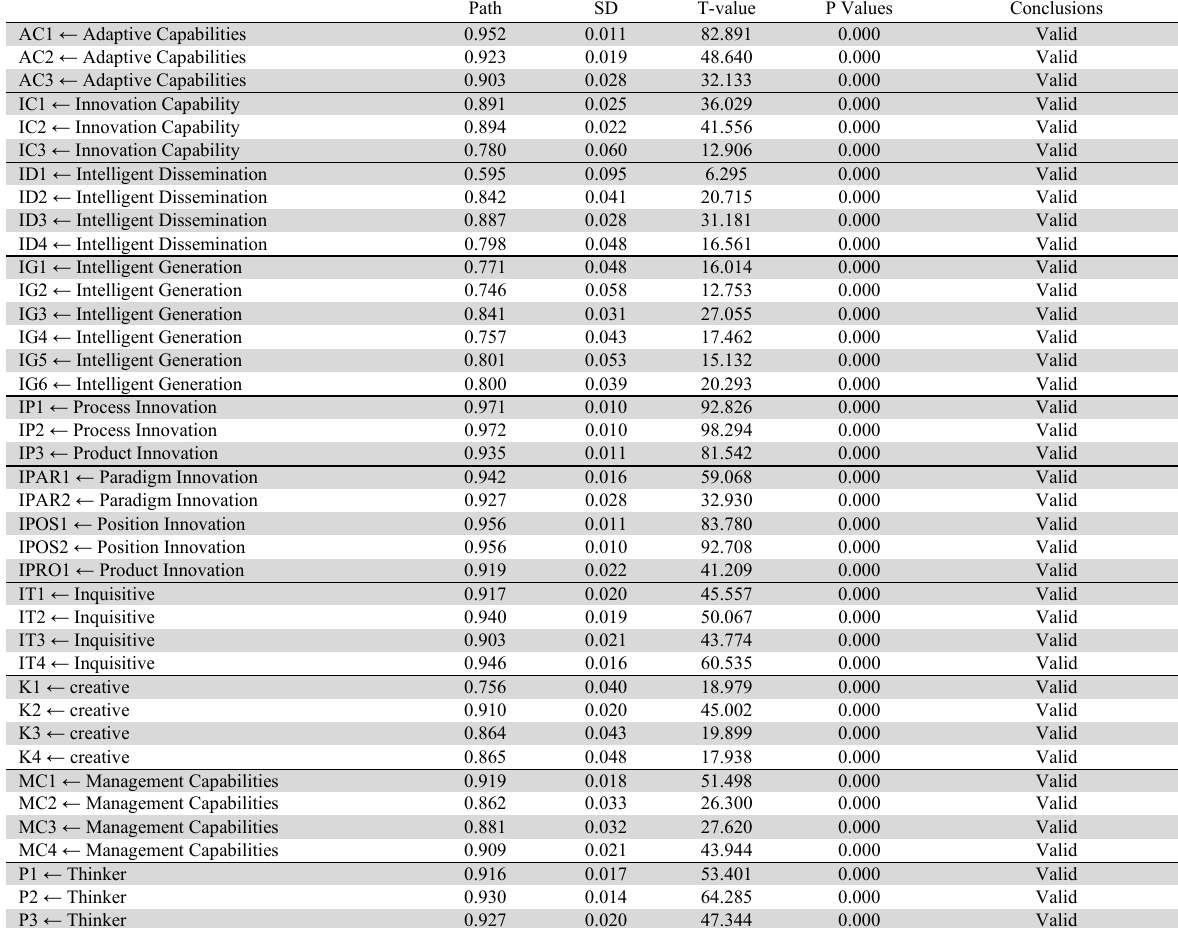
The results of outer loading